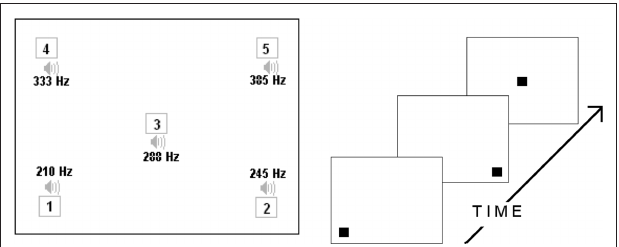
Figure 1 | Left: The large rectangle represents the layout of the computer screen for experiments 1 and 2. The five numbered boxes show the five possible locations of the visual stimuli and beside them are the five possible tones (in Hz) associated with each location. Right: A graphical representation of the visual sequence “1 2 3” as it would have